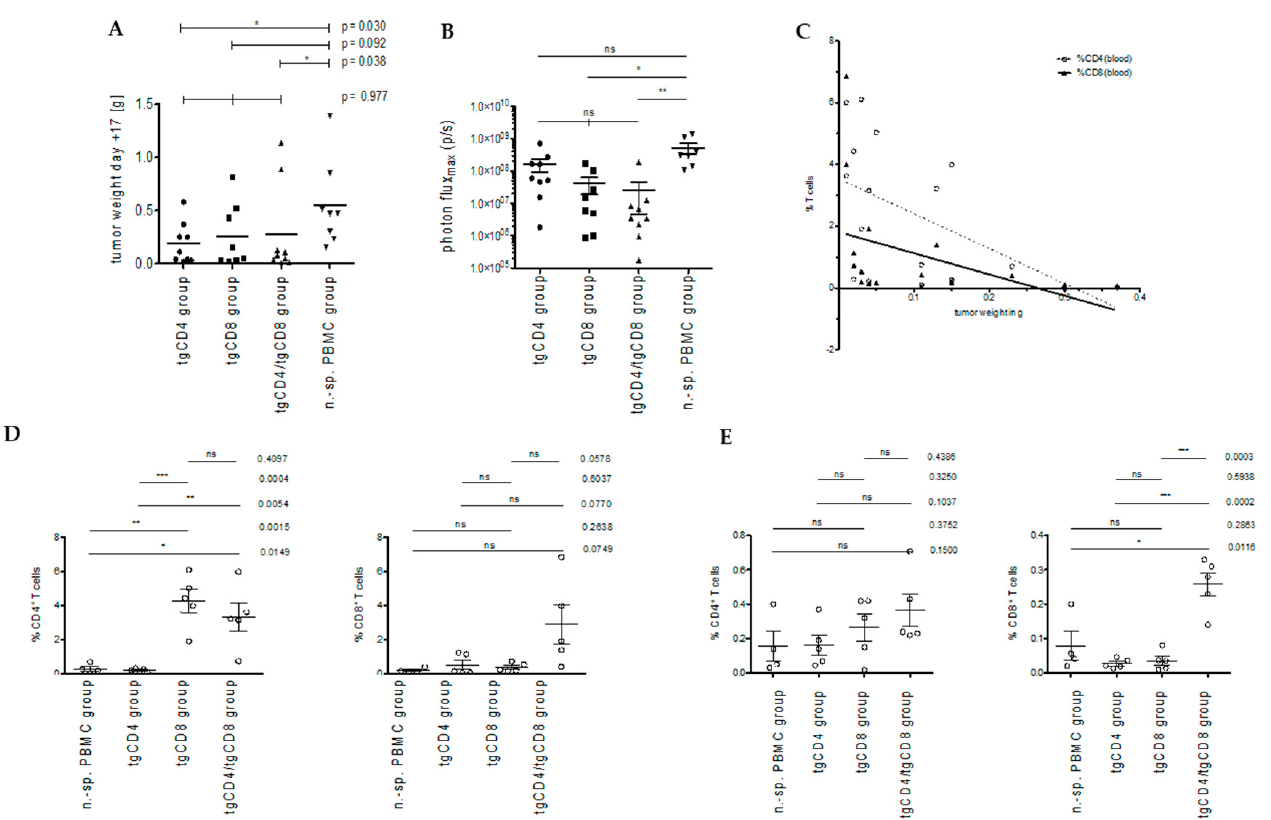
Figure 4. Local tumor control and human T cell frequencies in blood in vivo. Antitumor activity in treatment groups (tgCD4, tgCD8, tgCD4 / tgCD8, and n.-sp-PBMC) the end of experiment (day + 17) indicated as tumor weight ( A ) and bioluminescence ( B ), each dot corresponds to an animal. ( C ) Linear regression modeling of tumor weight, CD4 + and CD8 + T cell frequencies in blood of corresponding animals. Human T cell frequencies (%) in specific lymphocyte gate, depicted for CD4 + (left) and CD8 + T cells (right) in blood ( D ) and spleen ( E ) in respective treatment groups ( n = 5 per group). Error bars represent the SEM. Asterisks indicate significance levels. * p < 0.05; ** p < 0.005; *** p < 0.0005; ns = not significant.